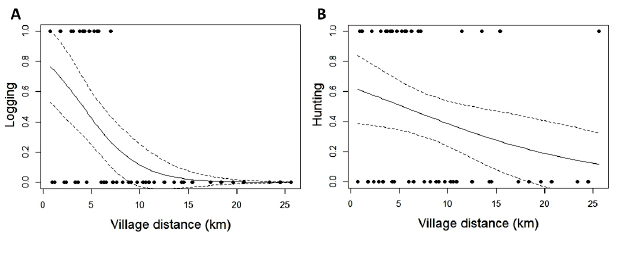
Fig. 2 . Presence of wood extraction (A) and hunting (B) in the sites surveyed in relation to village distance. The black line indicates the fitted relationship according to the generalized linear